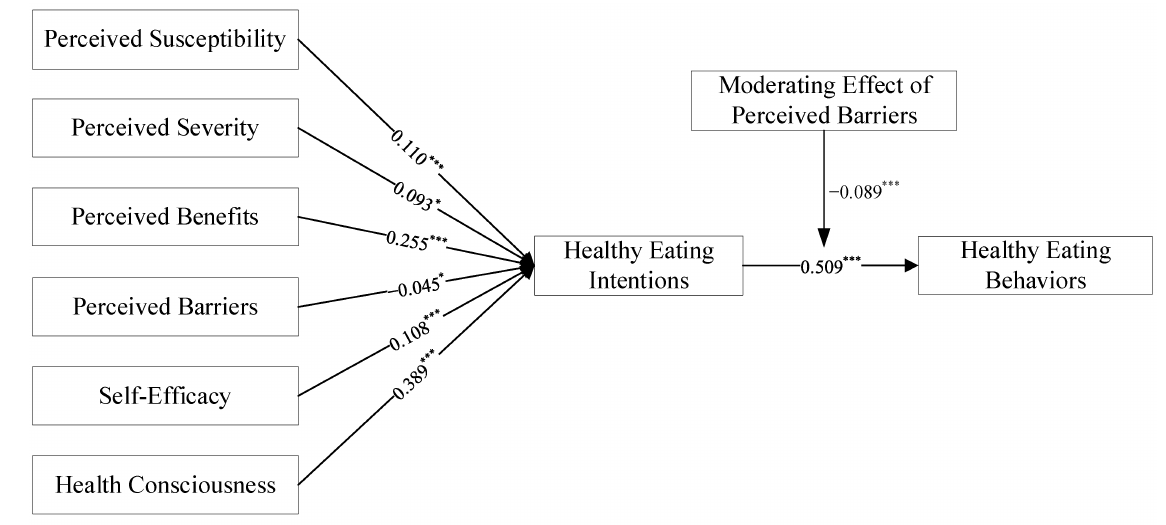
Figure 2. Structural model with path weight and significance level; Note: * and *** indicate significant at the 10%, and 1% significance levels,